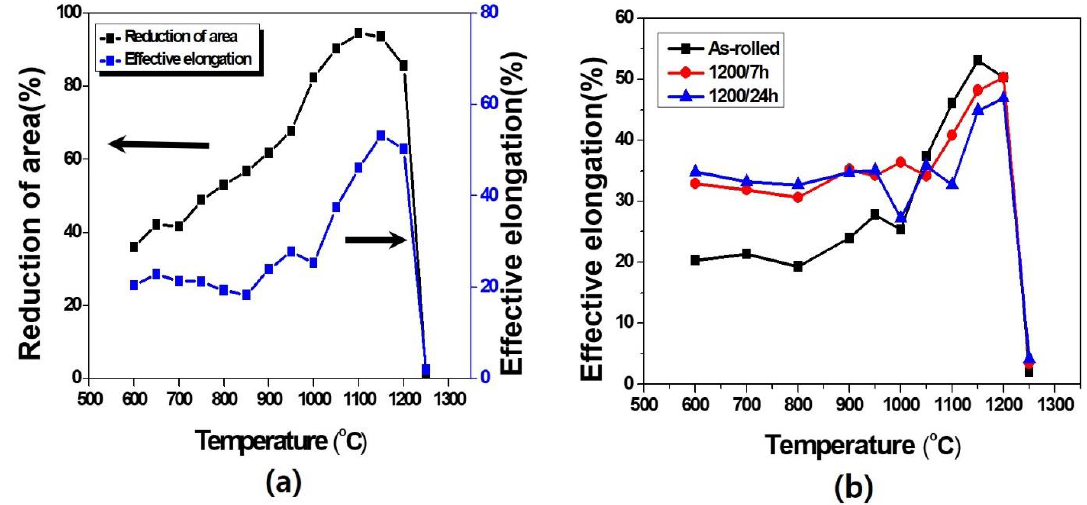
Figure 9. ( a ) Effective elongation-to-fracture for as-rolled Fe-Cr-Mn-Ni stainless steel, plotted along with the reduction of area as a function of temperature. ( b ) Effective elongation-to-fracture for as-rolled Fe-Cr-Mn-Ni stainless steel and those annealed at 1200 °C, plotted as a function of temperature.